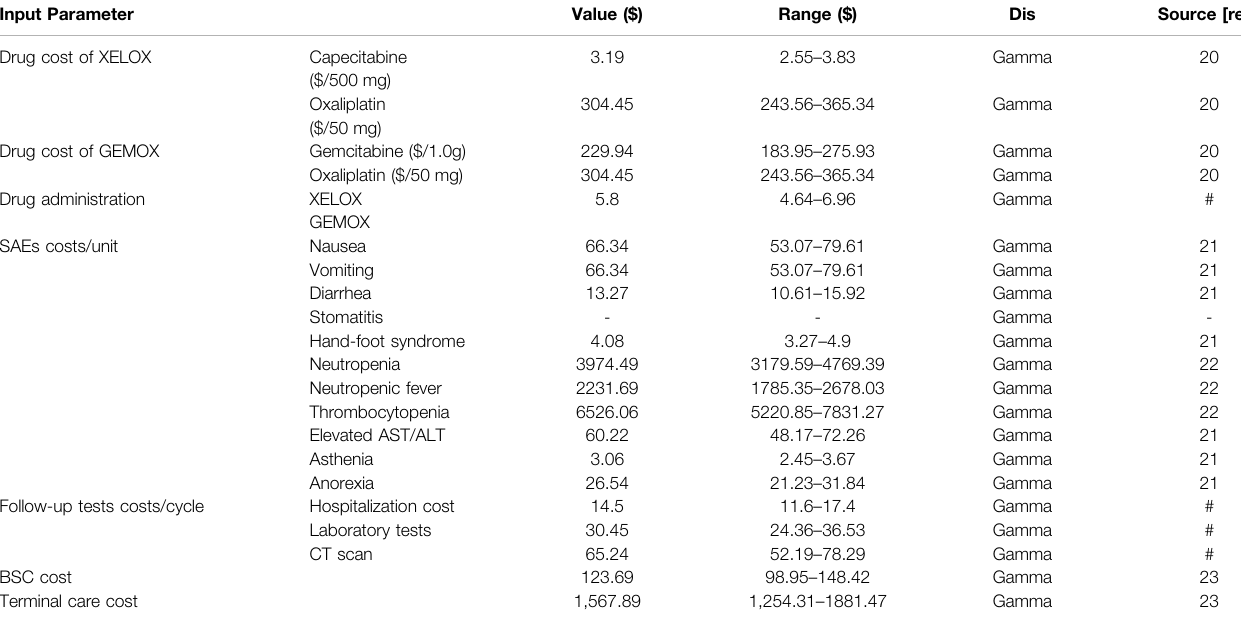
TABLE 3 | Cost parameters.